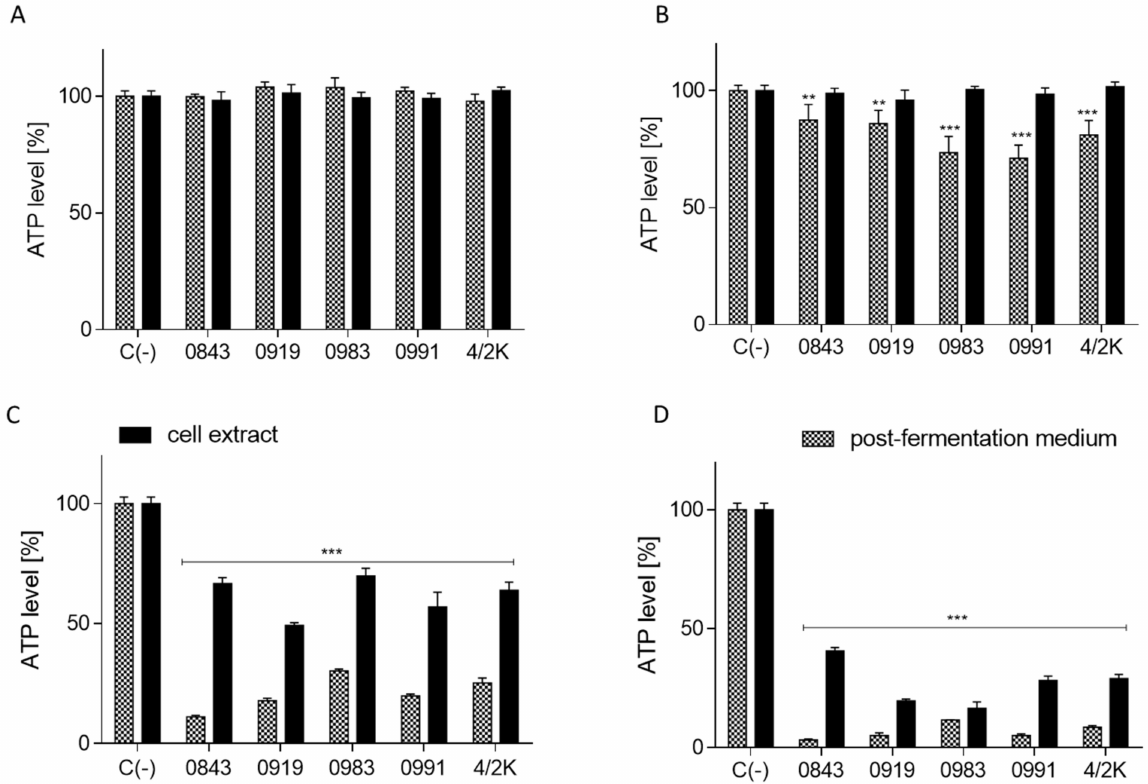
Figure 4. The effect of post-fermentation media (PFM) or cell extracts (CEs) at concentrations ( v/v ) of 0.1% ( A ), 1% ( B ), 10% ( C ), or 20% ( D ) on ATP level in Caco-2 cells after 24 h incubation; values are means ± SD, n ≥ 4; statistical significance was calculated versus control cells (untreated), * p ≤ 0.05, ** p ≤ 0.01, *** p ≤ 0.001.